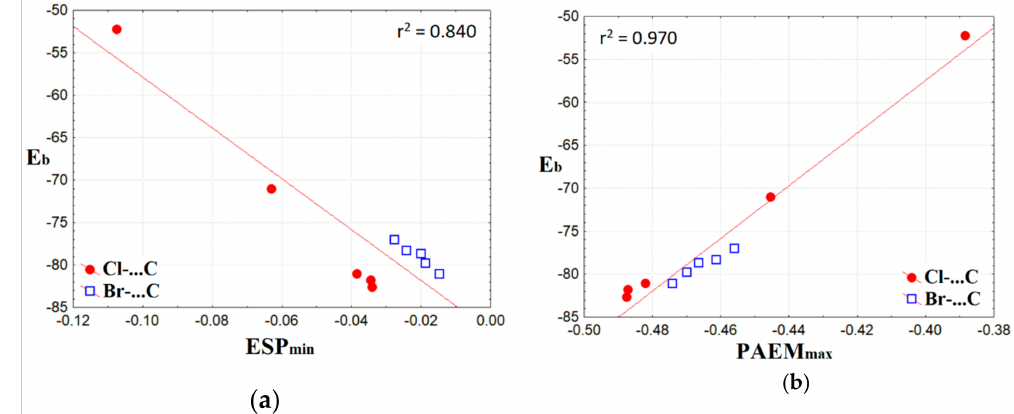
Figure 6. Binding energy in complexes vs minimum of electrostatic potential ( a ) and maximum of potential acting on an electron in a molecule, ( b ) along the line of tetrel bonds.